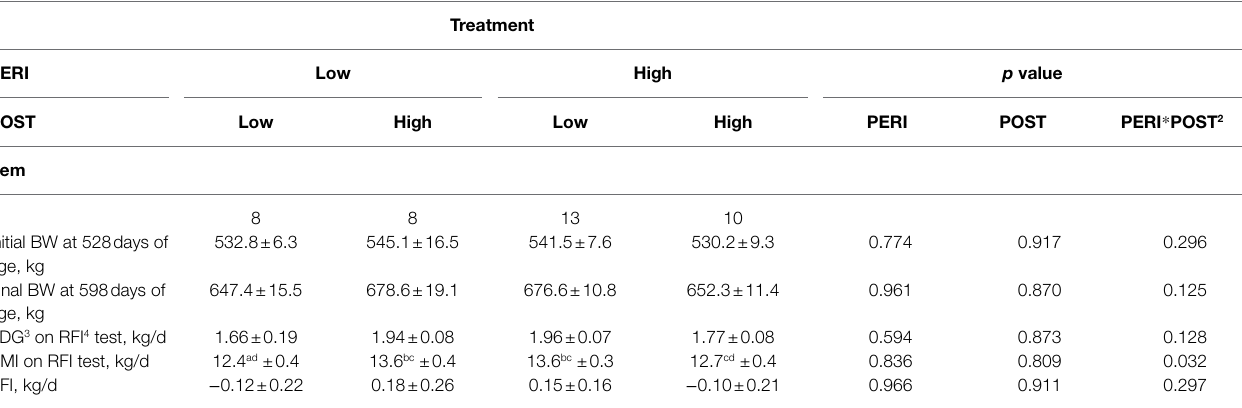
TABLE 3 | Performance of bulls during 70 days residual feed intake test following exposure to maternal diets low or high in protein during the peri-conception and first trimester periods of gestation 1 . Treatment